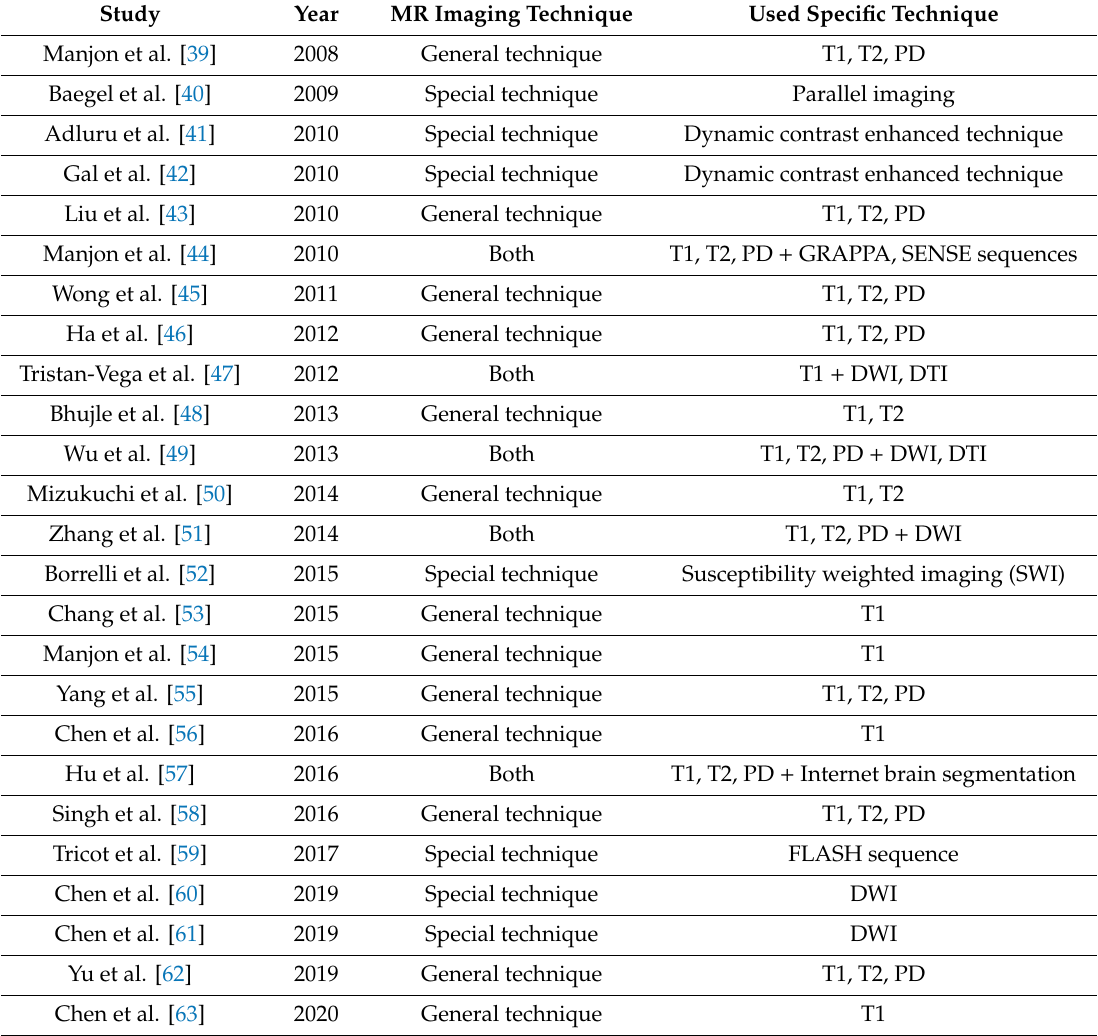
Table 2. Characteristics for MR imaging techniques from studies retrieved for systematic